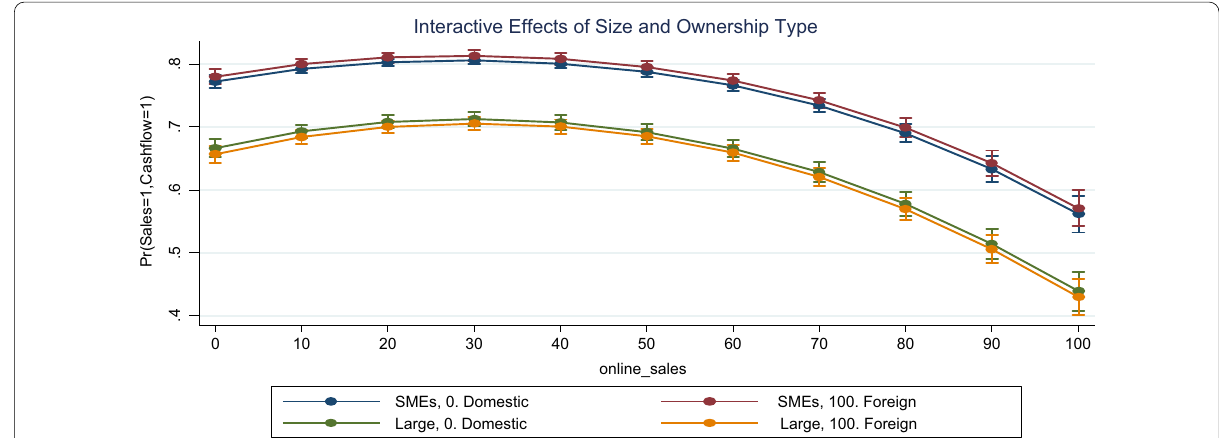
Fig. 4 Interactive effects of size and ownership type on the relationship between online sales and financial resilience. Source : authors’ construct based on Covid-19 ES follow-up survey